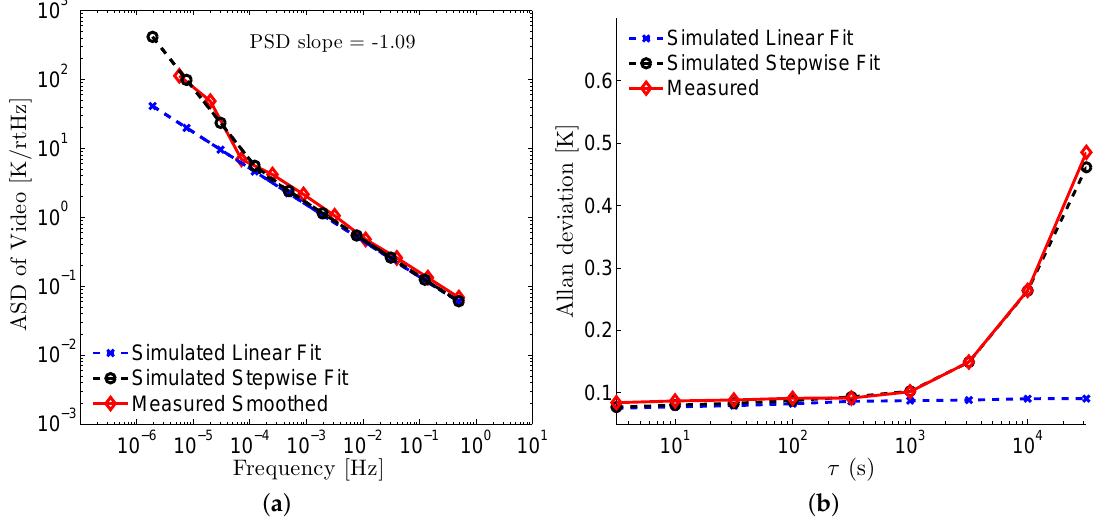
Figure 2. ( a ) Amplitude spectral density of the radiometer noise. The noise represents 300 K scene brightness temperature. Note that the noise spectra are referred to the input of the radiometer (to its calibration plane); ( b ) Allan deviation of the radiometer video signal reduced to the input of the radiometer. τ is the integration time of the video